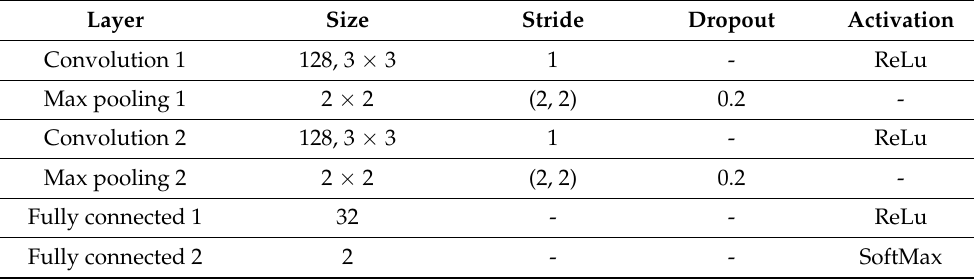
Figure 13. The Architecture of the CNN model for acoustic classification. Table 2. Parameters of the developed CNN model for acoustic